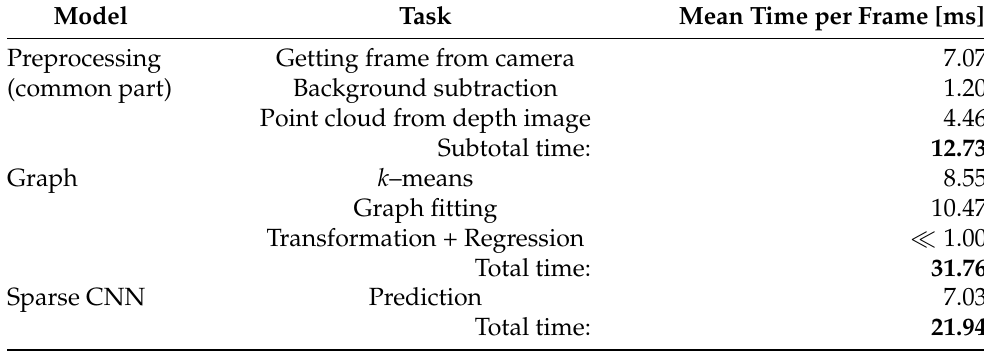
Figure 10. Comparison of the angle prediction accuracy for graph fitting and sparse CNN on the training data set, learned on the image from the left camera. The shaded area indicates that the robotic arm is in front of the camera. Table 4. Processing time divided into subsequent operations according to the pipeline presented in Figure